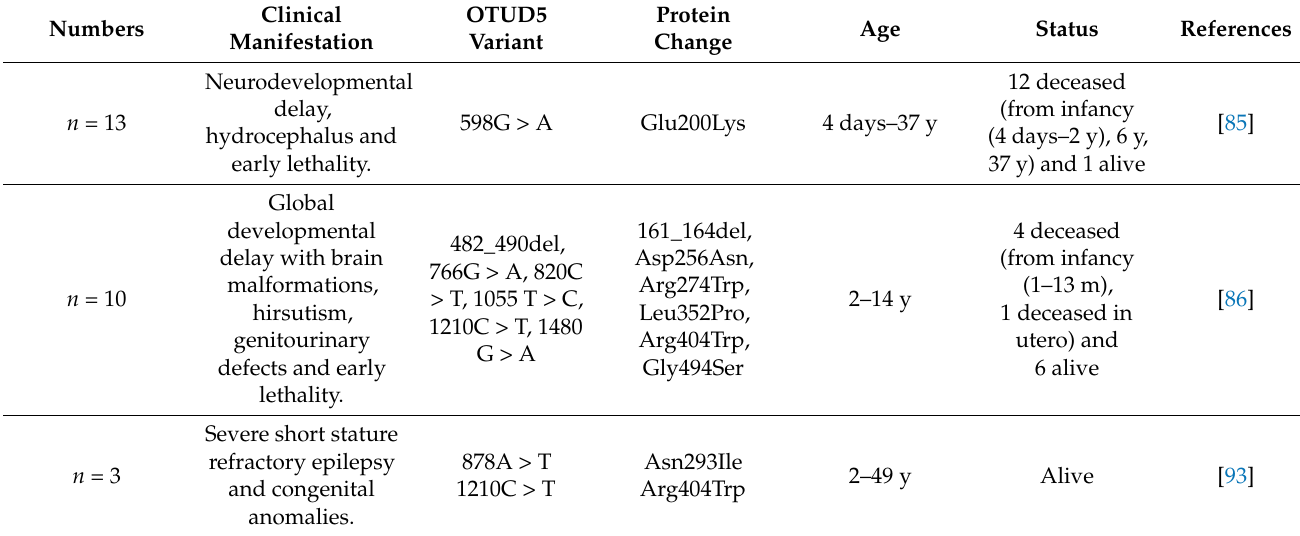
Table 2. Clinical features of patients with OTUD5